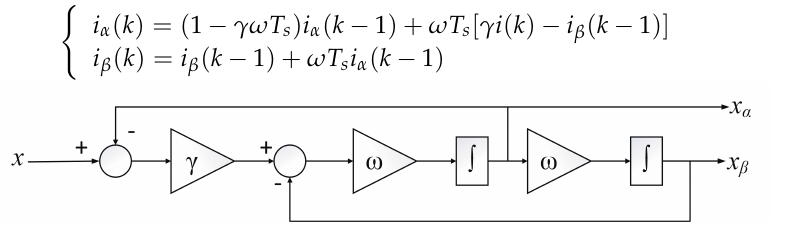
Figure 4. Scheme for Second Order Generalized Integrator